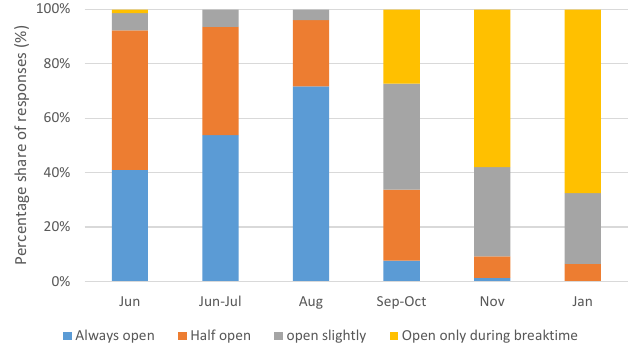
Figure 5. Results from window-opening ventilation.